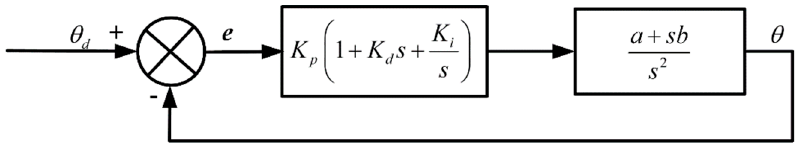
Figure 6. System proportion integration differentiation (PID) closed-loop control block diagram.